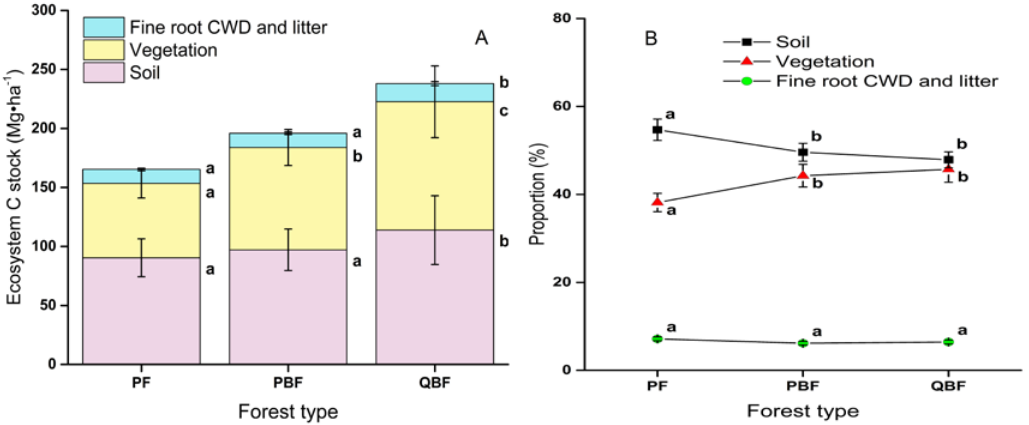
Figure 5. Ecosystem carbon stocks ( A ) and contribution proportions ( B ) of the various components in the pure Pinus tabuliformis forest (PF), pine-broadleaved mixed forest (PBF) and Quercus -broadleaved mixed forest (QBF) in the central Loess Plateau of China. a, b, and c indicate significant di ff erences in the carbon stocks of the same components at di ff erent succession stages at p = 0.05.